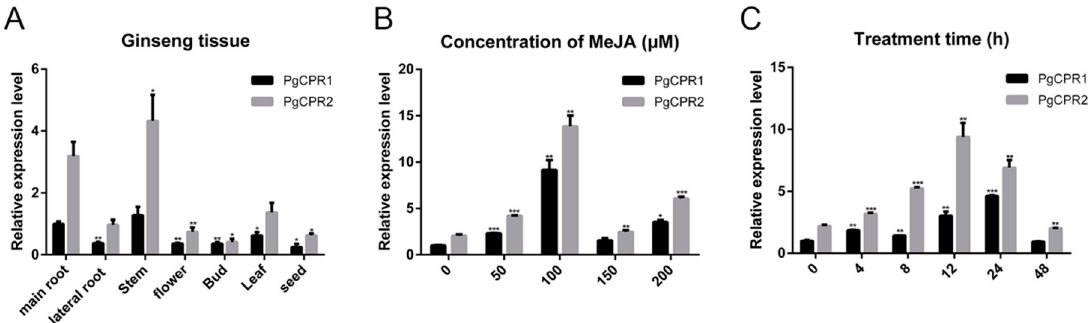
Figure 5. Expression analysis of PgCPRs. ( A ) The relative expression level of PgCPRs in different tissues of ginseng was calculated by using the expression level of PgCPR1 at the main root as standard 1. ( B ) The expression level of PgCPR1 at 0 μ M MeJA was used as standard 1 to calculate the relative expression level of PgCPRs in different concentrations of MeJA at 24 h. ( C ) The expression level of PgCPRs at different time points was induced by 100 μ M MeJA. The expression level of PgCPR1 at 0 h was used as the standard. All the above expression levels were standardized according to the expression level of β -actin. The standard deviation of three independent repeated tests is expressed by error bars. The asterisk indicates that there is significant difference in t-test, * p < 0.05, ** p < 0.01, *** p < 0.001.